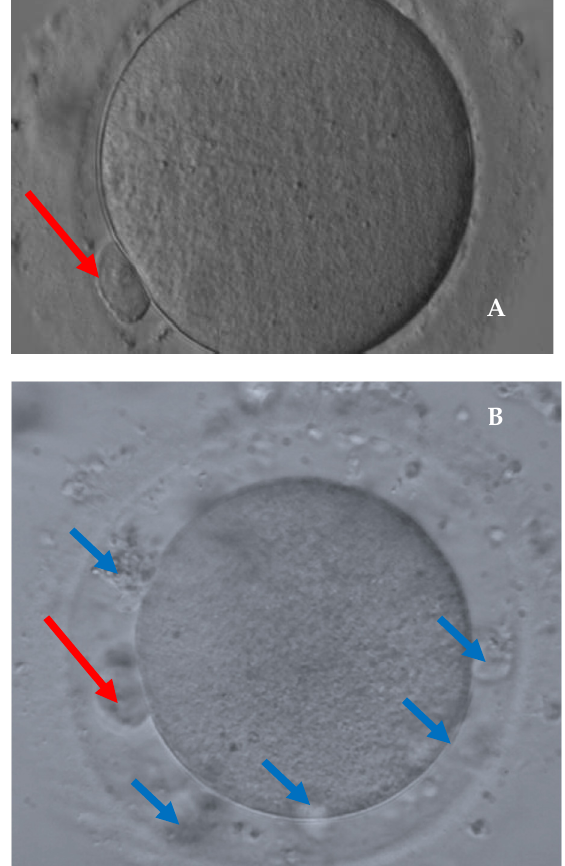
Figure 1. Details of dysmorphic oocytes: ( A )cytoplasmic dimorphism with a burned-look alteration and ( B ) large perivitelline space with granules. Oocytes showed fragmented cytoplasm ( A : 200×; B 400×).